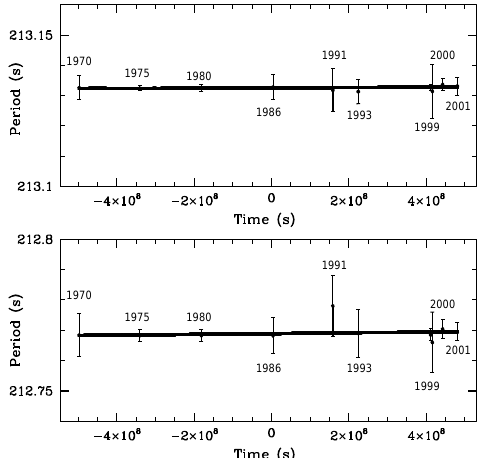
Fig. 2. Direct method: the best seasonal periods vs time for the 213 s doublet and is useful in ruling out large values of ˙P . The top panel shows the best fit ˙P = (4.8 ± 1.2) × 10 − 13 s/s for P the lower panel indicates the best fit ˙P = (12.5 ± 4.1) × 10 − 13 s/s for P 212.7689 ± 0.0002 s.